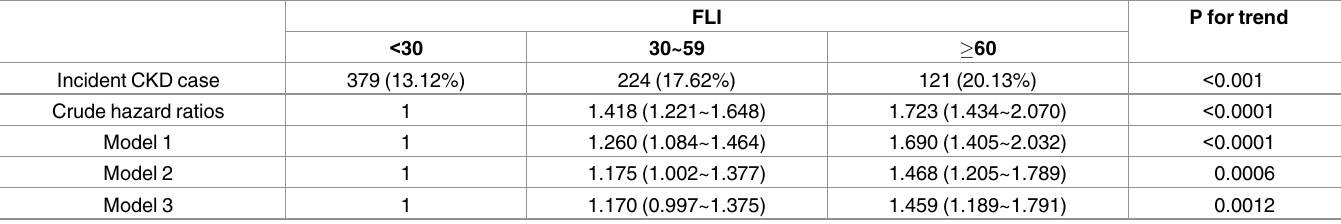
Table 3. Hazard ratios (95% Confidence interval) for incident CKD according to the FLI